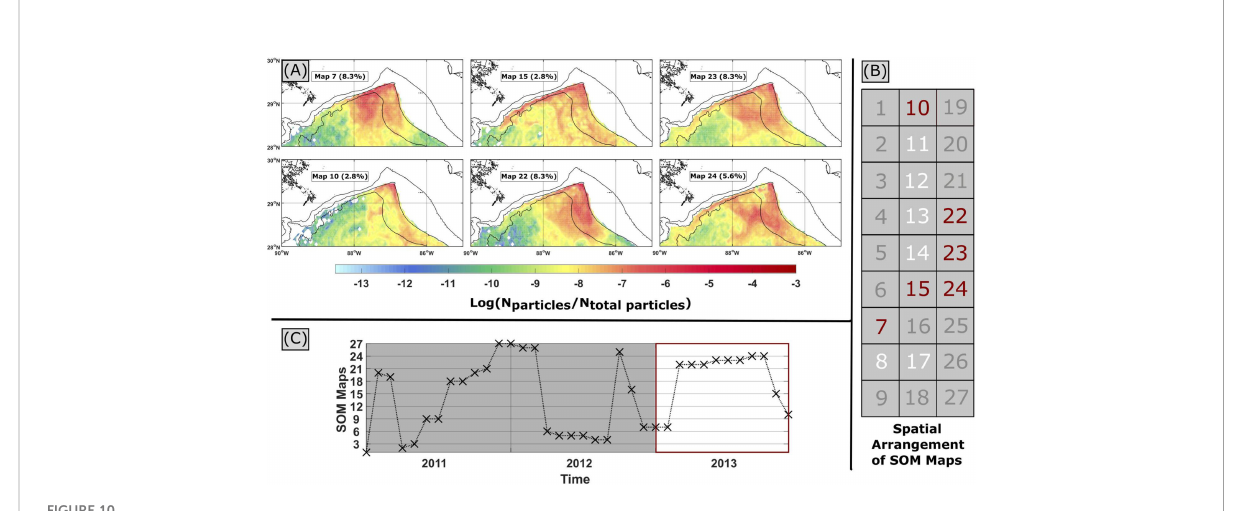
FIGURE 10 Same as Figure 8, but for